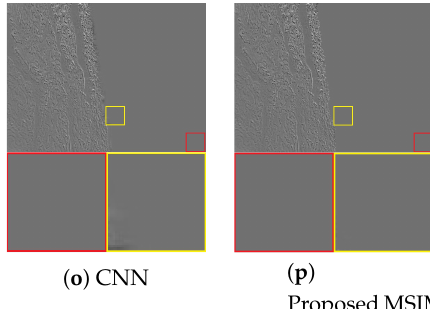
Figure 8. Results of image fusion and their difference images on the “Girl” source images. ( c – i ) Fused images obtained through fusion schemes. ( j – p ) Difference images obtained from the fusion results and Figure